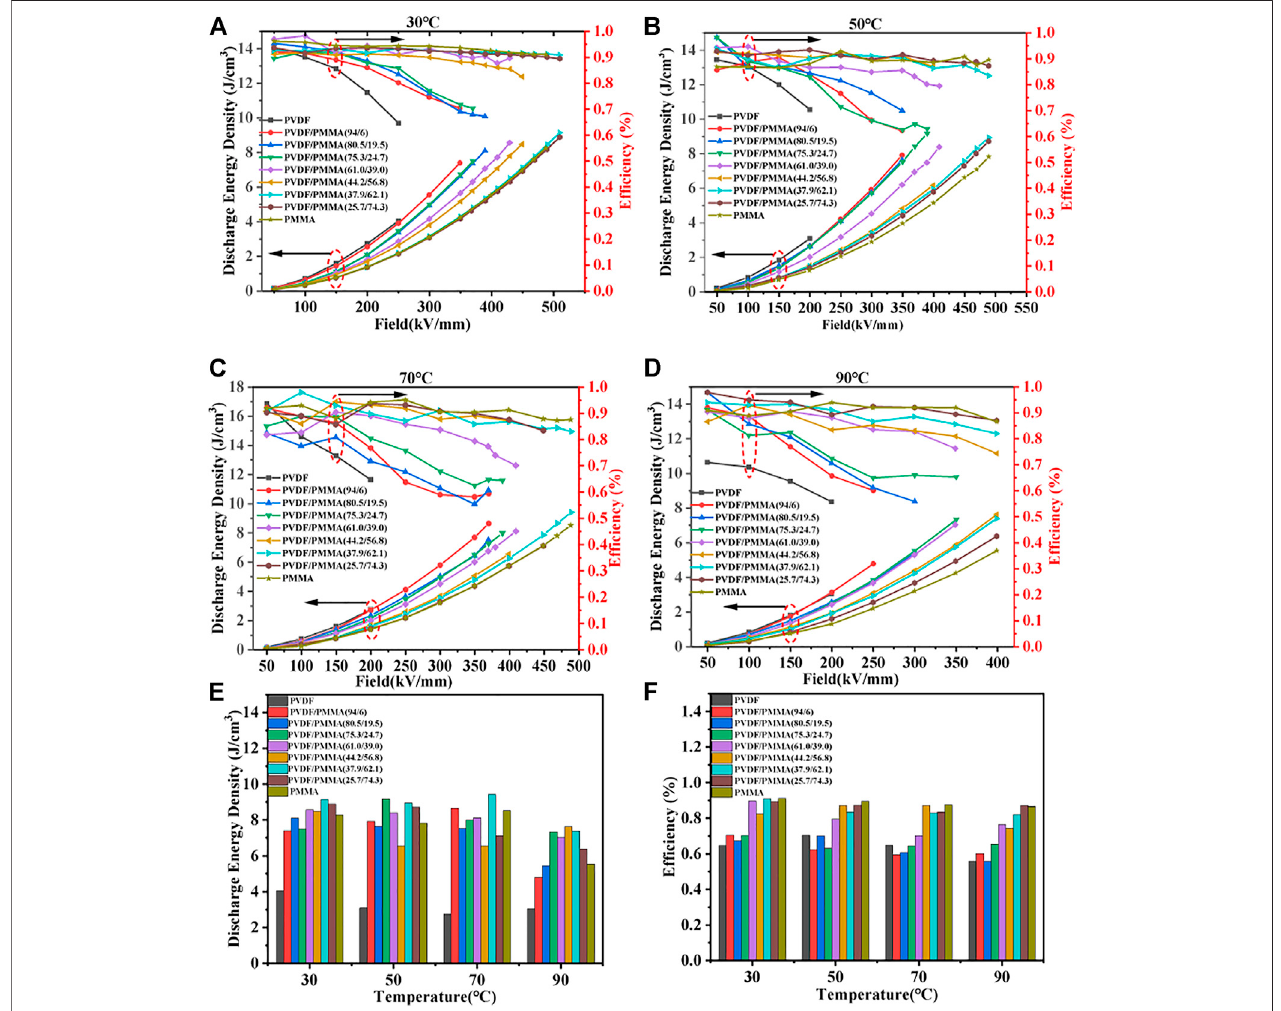
FIGURE7| Energydensitiesandef fi cienciesofPVDF/PMMAblendsat (A) 30 ° C, (B) 50 ° C, (C) 70 ° C,and (D) 90 ° Candthecomparisonofvariationsof (E) maximum energy density and (F) ef fi ciency with temperature.